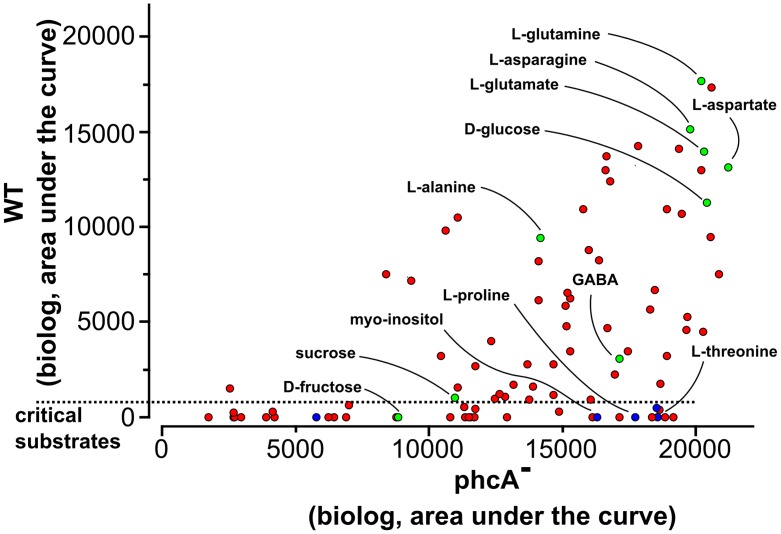
Cost of virulence factor production impairs growth on critical substrates.Comparison of the substrate usage capacity inferred from biolog phenotype microarray between the wild-type strain and the phcA mutant and its ability to support bacterial proliferation. Labeled compounds are carbon substrates known to be present in planta (xylem or apoplast) at a concentration >90 μM (in green) or lower concentration (in blue) [36]. Critical substrates which do not sustain a bacterial growth <5% of the maximal substrate usage capacity are those located below the dashed line.